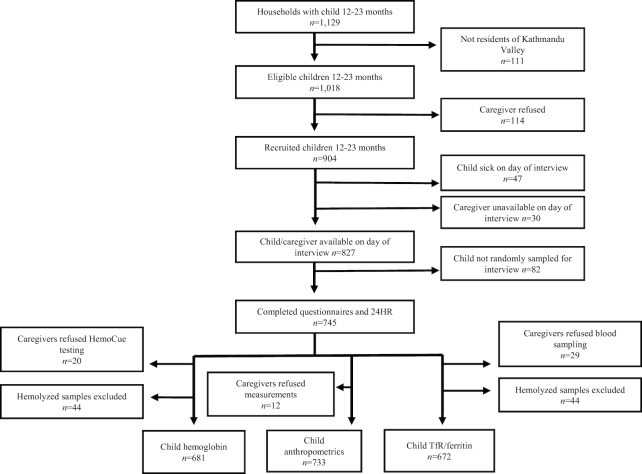
Participant recruitment, exclusion, and inclusion. TfR, soluble transferrin receptor; 24HR, multiple-pass 24-h recall.